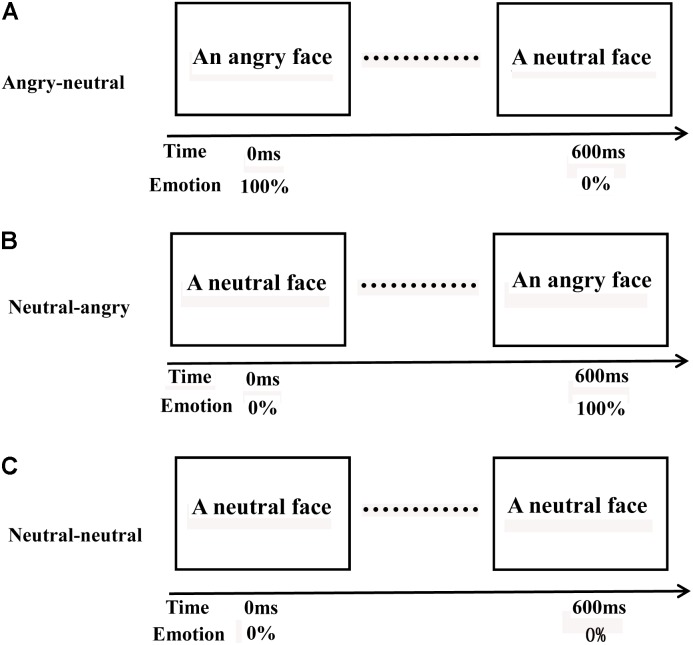
Three different videos of facial emotional changes. Angry-neutral videos (A): an angry face changed to a neutral face; neutral-angry videos (B): a neutral face changed to an angry face; and neutral-neutral videos (C): a neutral face changed to a neutral face.